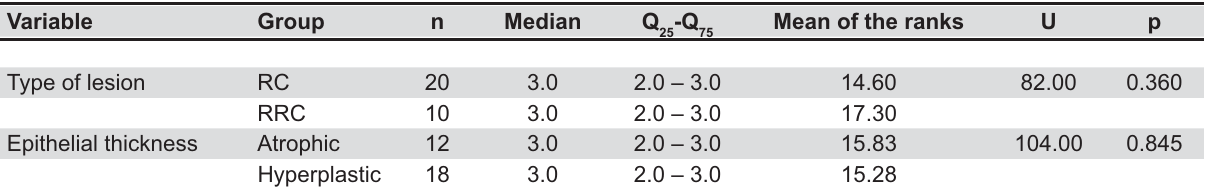
Table 3- Parameters used for the calculation of the Mann-Whitney U test for the evaluation of the epithelial expression of vascular endothelial growth factor (VEGF) according to the type of lesion and epithelial thickness